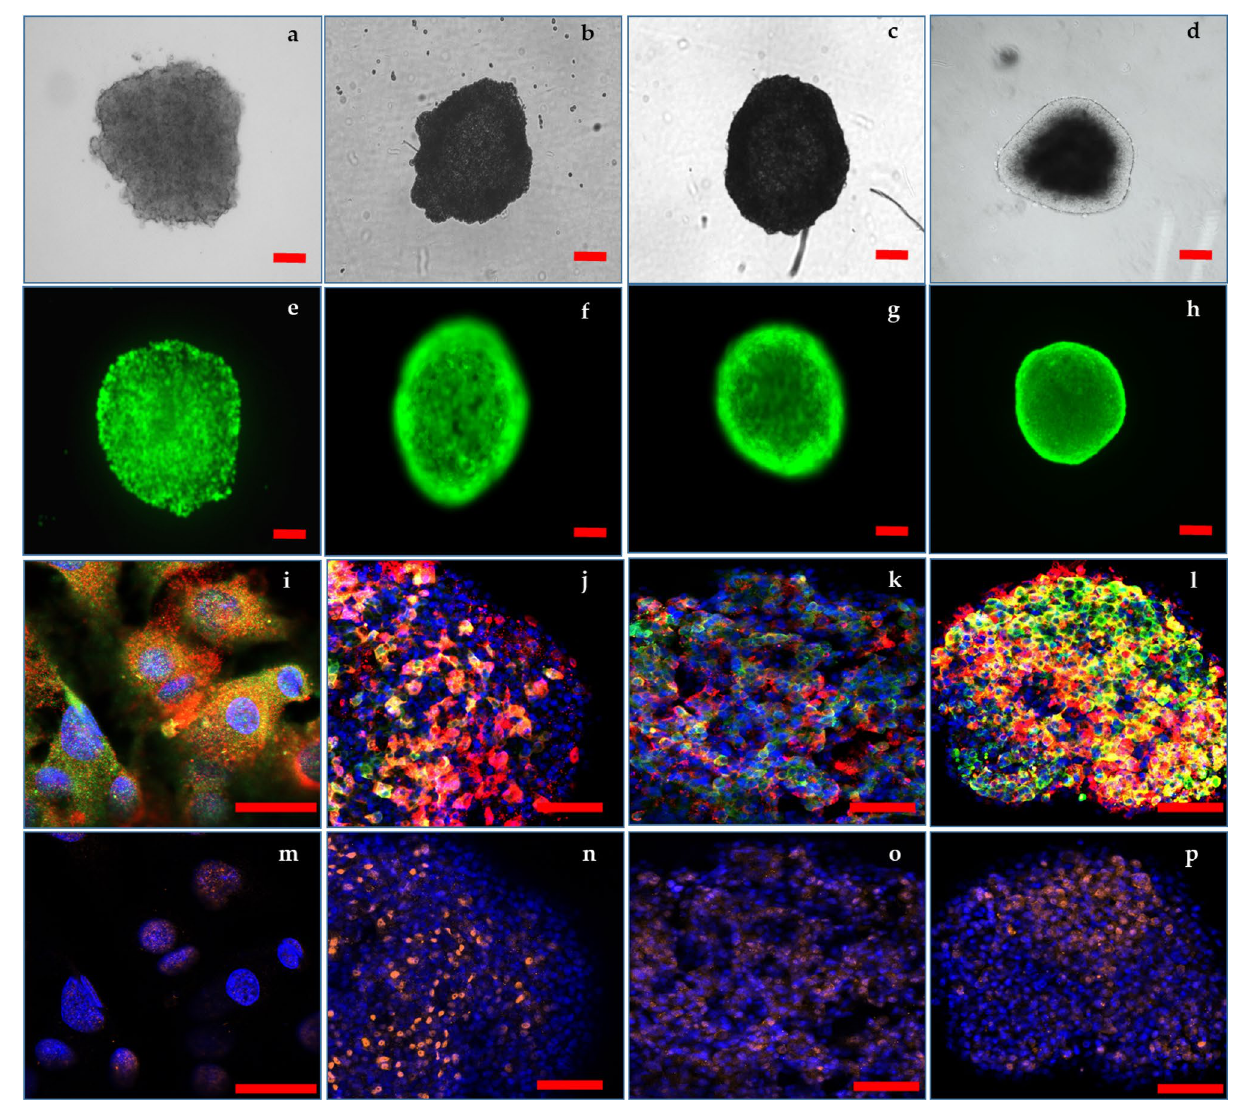
Figure 3. Images of the progression of HepG2 spheroids over a time course of 6 weeks in culture. Light micrographs depicting HepG2 spheroids at Days 14 ( a ), 21 ( b ), 28 ( c ), and 42 ( d ) post-seeding. Fluorescent micrographs of HepG2 spheroids at Days 14 ( e ), 21 ( f ), 28 ( g ) and 42 ( h ) stained with FDA and PI showing maintenance of esterase activity and no evidence of compromised cell membranes. Confocal images of cleared HepG2 monolayers ( i ) and cleared spheroids at Days 14 ( j ), 21 ( k ), 28 ( l ), stained with DAPI (blue), ALB (green) and AFP (red). Confocal images of HepG2 monolayers ( m ) and cleared spheroids at Days 14 ( n ), 21 ( o ), 28 ( p ) stained with DAPI (blue) and HNF4α (orange). Scale bars 100 µm for spheroids and 20 µm for monolayers. Generated using Zeiss Zen Blue edition software 3.0 (https:// www. zeiss. com/ micro scopy/ int/ produ cts/ micro scope- softw are/ zen.